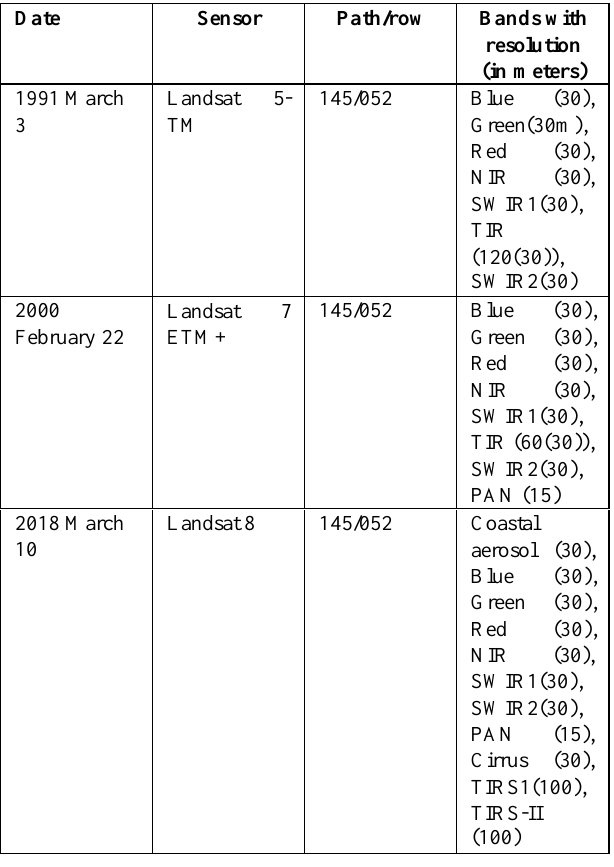
Figure 2: Landsat images of the study area for various years Table 1. Details of Satellite imageries used